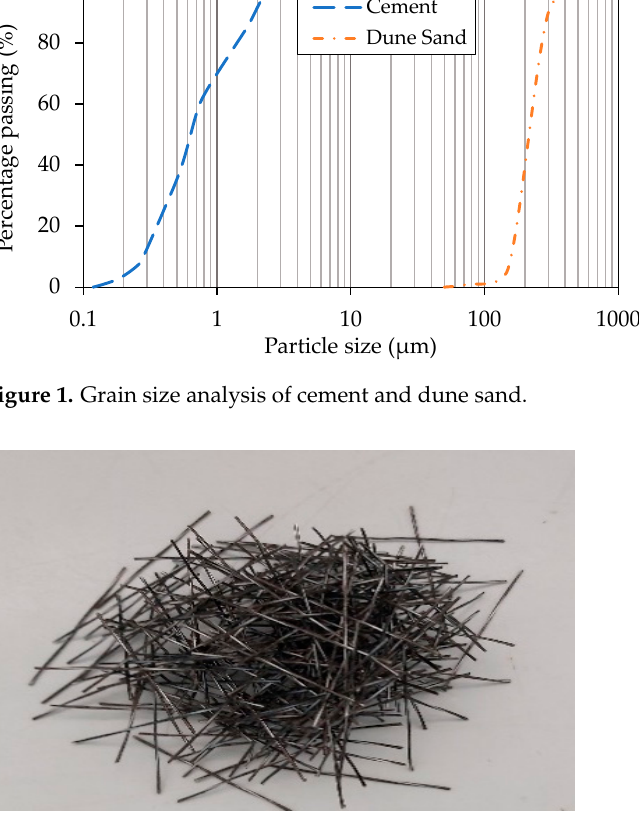
Figure 2. Physical appearance of BMF. Table 2. Physical characteristics of coarse aggregates and dune sand.